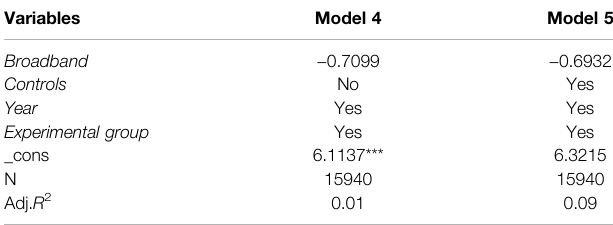
TABLE 4 | Results of placebo